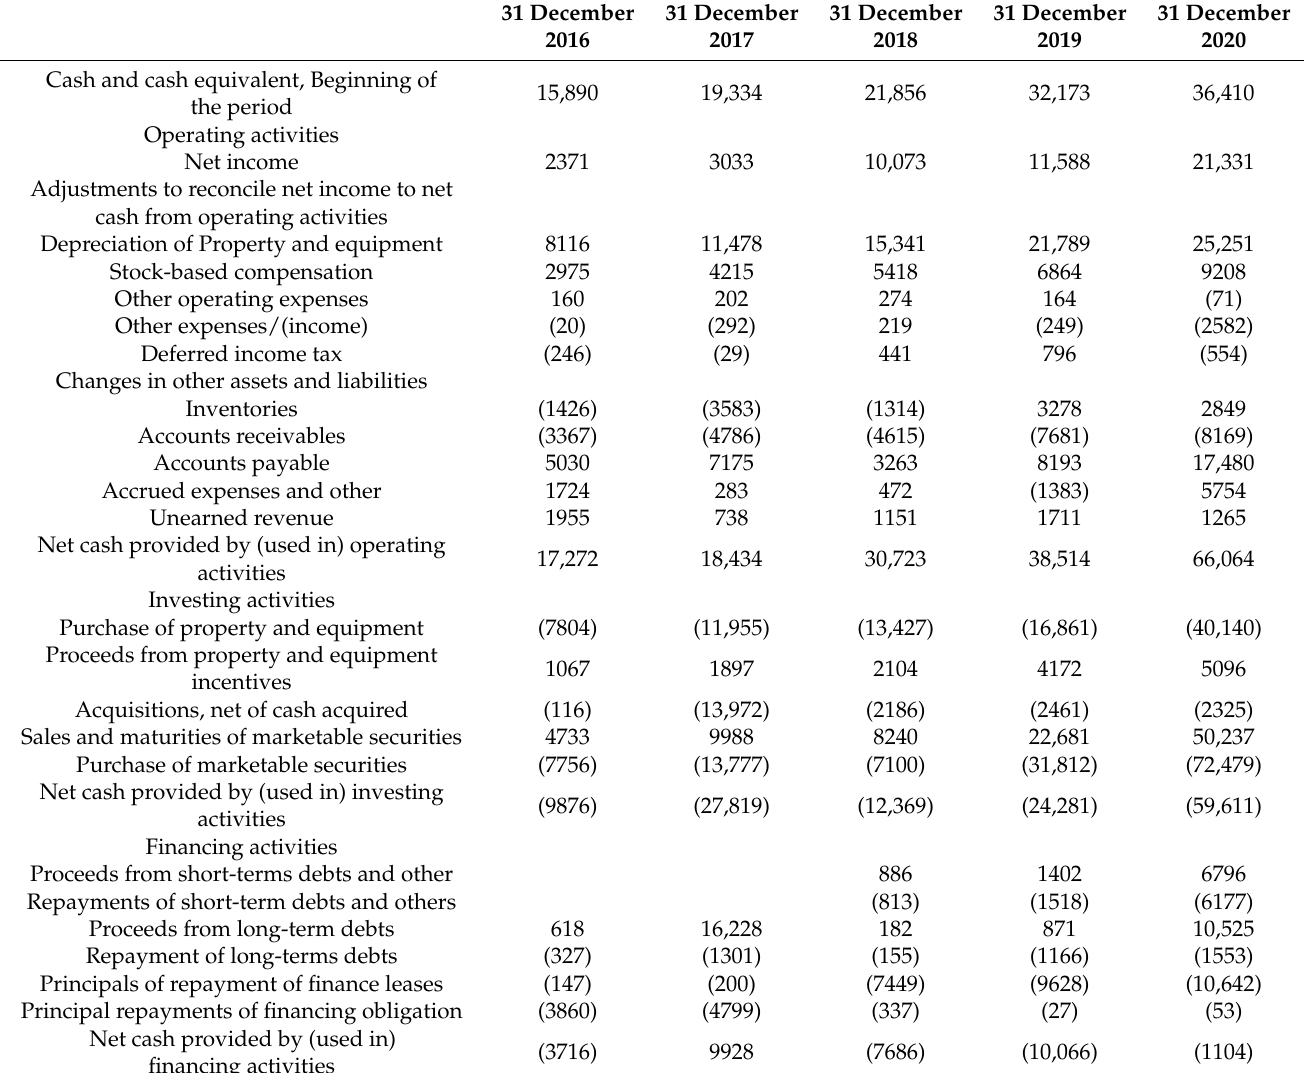
Table 4. Amazon’s cash flow